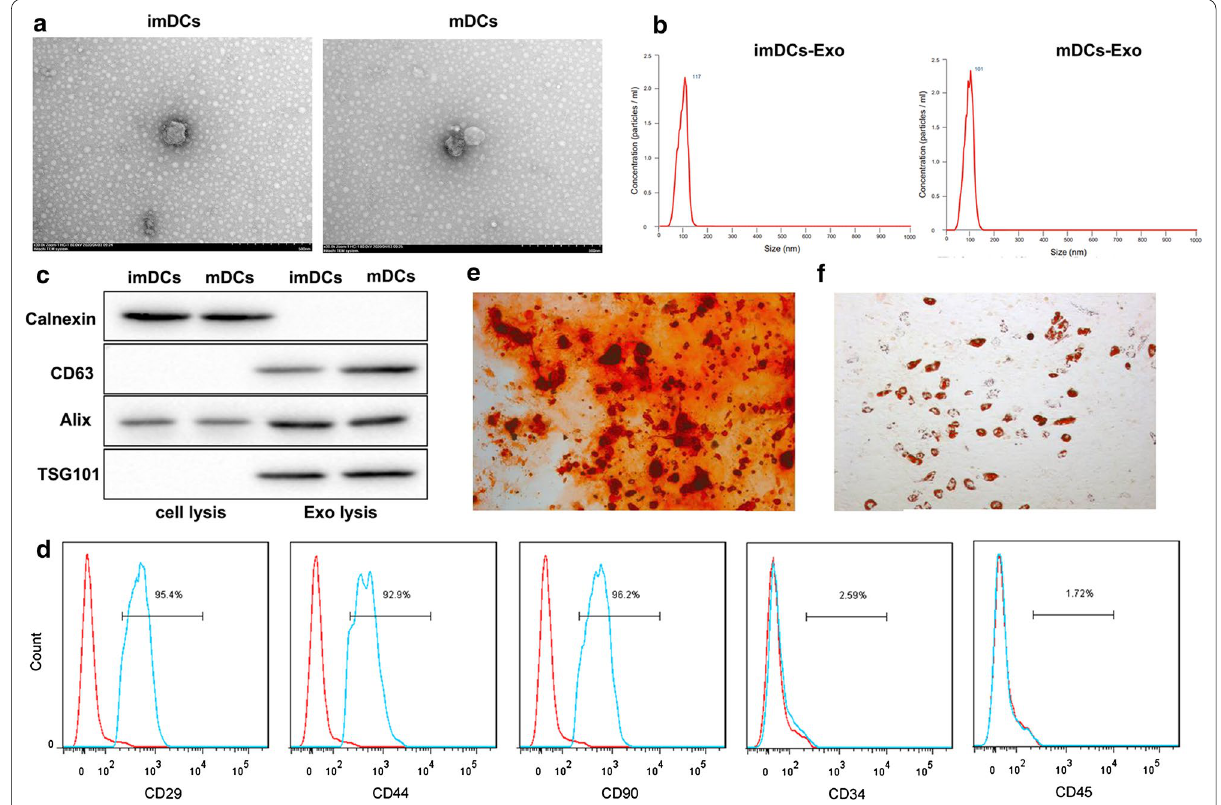
Fig. 1 Identification of exosomes and BM-MSCs. The exosomes isolated from imDCs and mDCs were referred to as imDCs-Exo and mDCs-Exo, respectively. a The morphological characterization of imDCs-Exo and mDCs-Exo by TEM. b The particle size of imDCs-Exo and mDCs-Exo measured using nanoparticle tracking analysis. c Expression of the exosomal markers (CD63, and Alix) and the exosome negative marker (Calnexin) confirmed by western blot. d The surface antigens including CD29, CD44, CD90, CD34, and CD45 of rat BM-MSCs was detected by flow cytometry. The positive rate of each surface marker was presented. e Osteogenic differentiation of BM-MSCs was confirmed by Alizarin Red staining. f Adipogenic differentiation of BM-MSCs was identified using Oil Red O